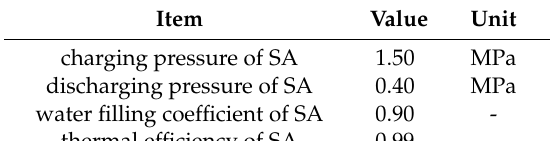
Table 3. Parameters of SA.